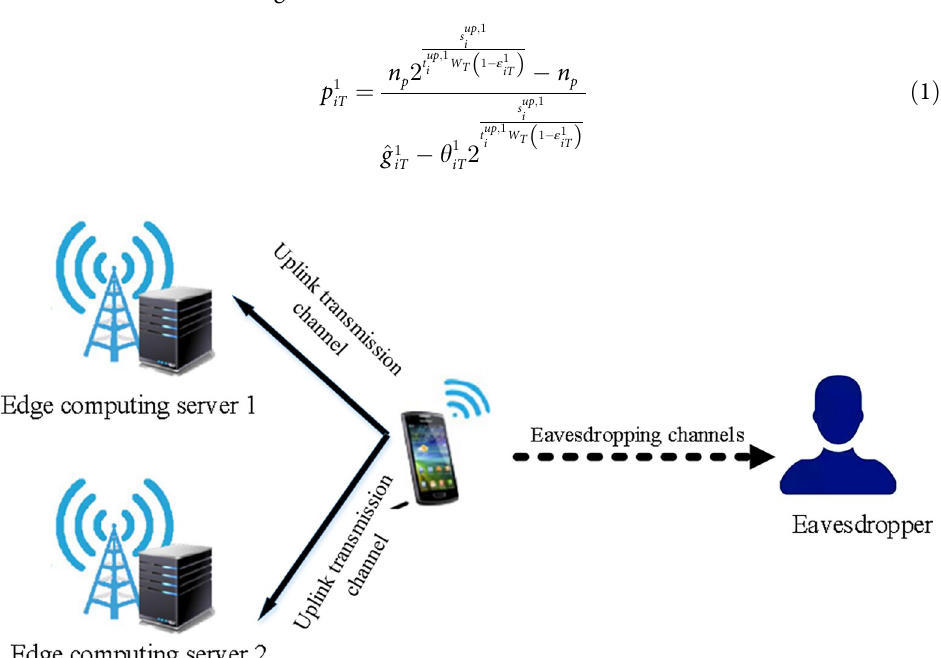
Fig 3. Data transmission